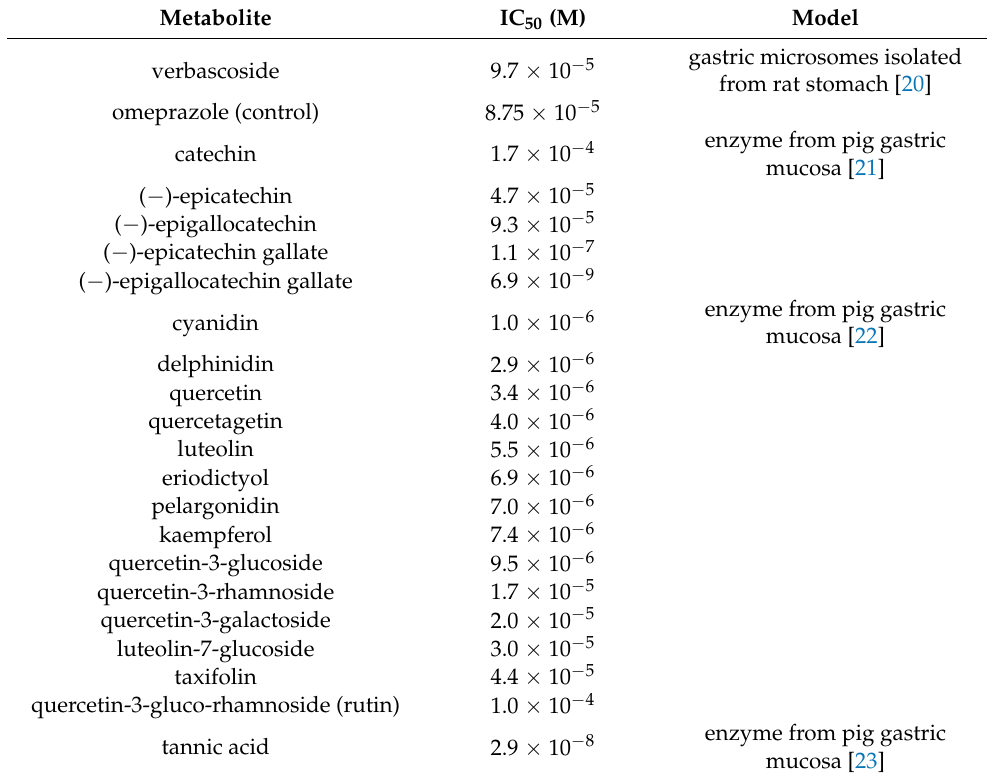
Table 1. In vitro H + /K + -ATPase inhibitory activity of plant secondary metabolites. Metabolite IC 50 (M)